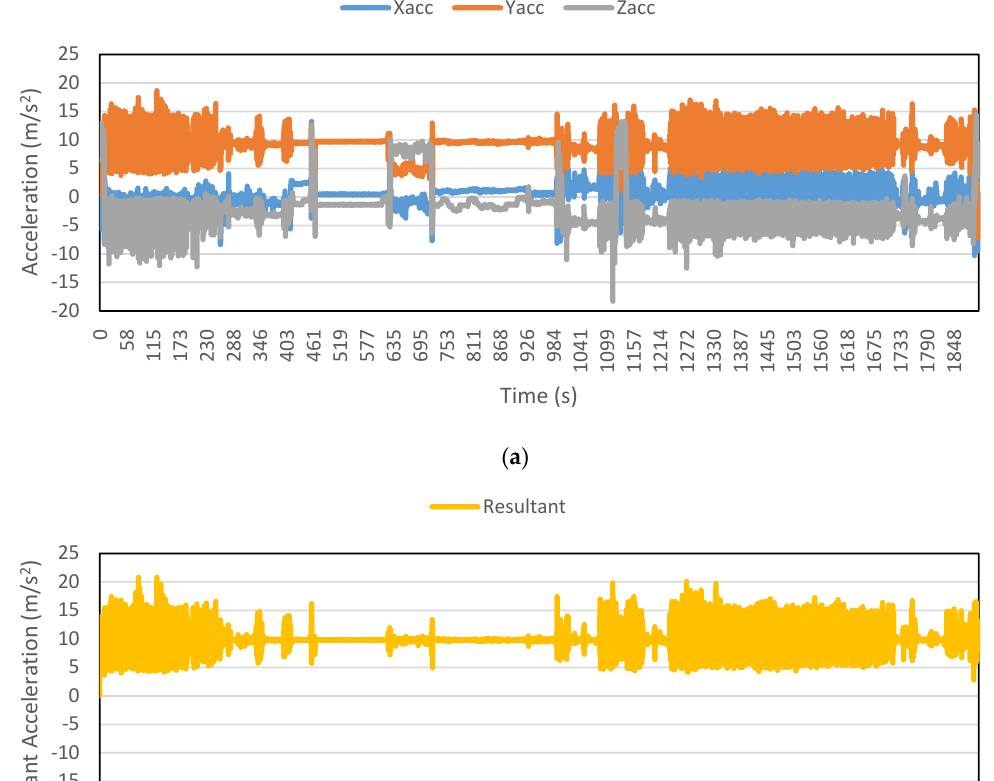
Figure 6. Accelerations recorded for a train trip: ( a ) Accelerations along three axes; and ( b ) Resultant acceleration.